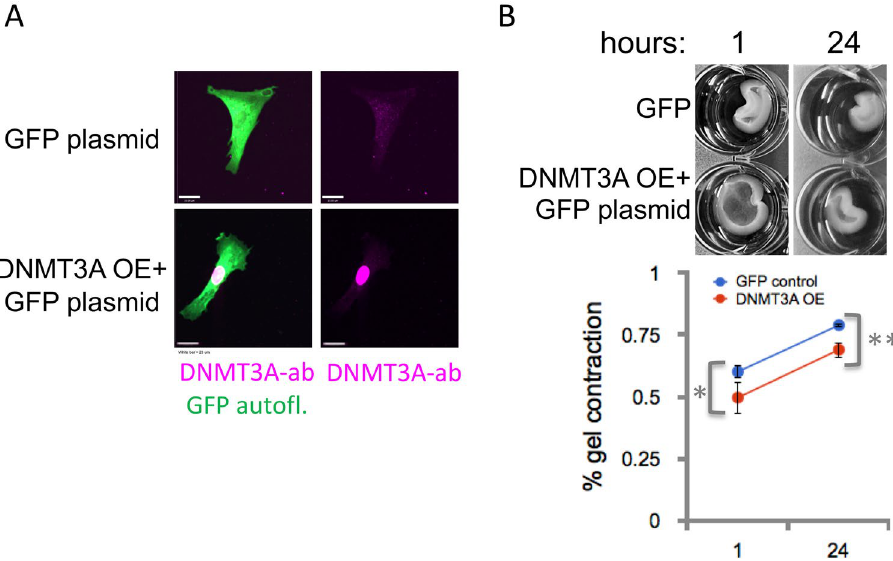
Figure 4. DNMT3A alters contractile function of bladder SMC. ( A ) Overexpression of DNMT3A + GFP (DNMT3A OE + GFP plasmid) vs. GFP plasmid alone was performed by nucleofection in human bladder SMC. Anti-DNMT3A (Magenta-far-red) detected a strong overexpression of DNMT3A in cells with GFP co-expression, representative image shown. All images at same magnification. White bar = 23 microns. ( B ) In parallel cultures, cells were plated onto collagen gels at 3 × 10 4 cells/mL in 24 well plates and allowed to grow 1 day prior to releasing gels from wells to allow for attachment and contraction. DNMT3A overexpression significantly decreased gel contraction, Overexpression was confirmed in parallel cultures. Representative photomicrographs shown. *p <